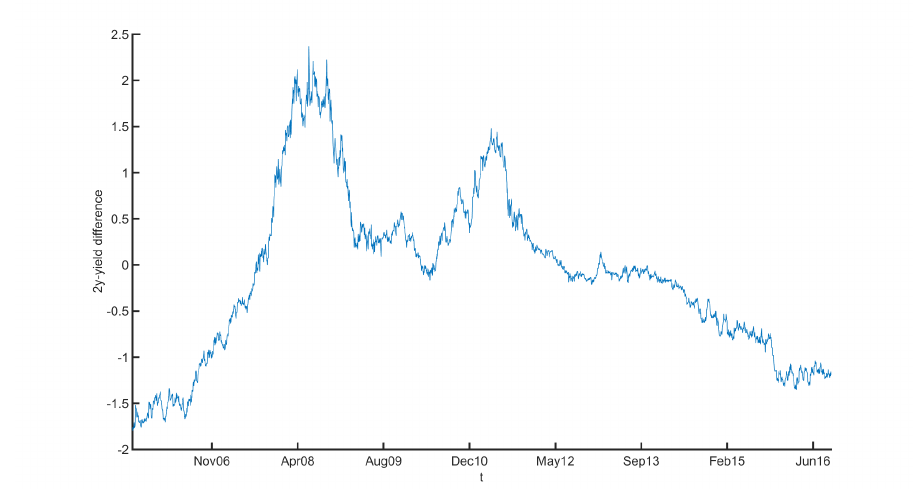
Figure 2. 2y-yield EURUSD differential from 15 August 2005–30 September 2016.